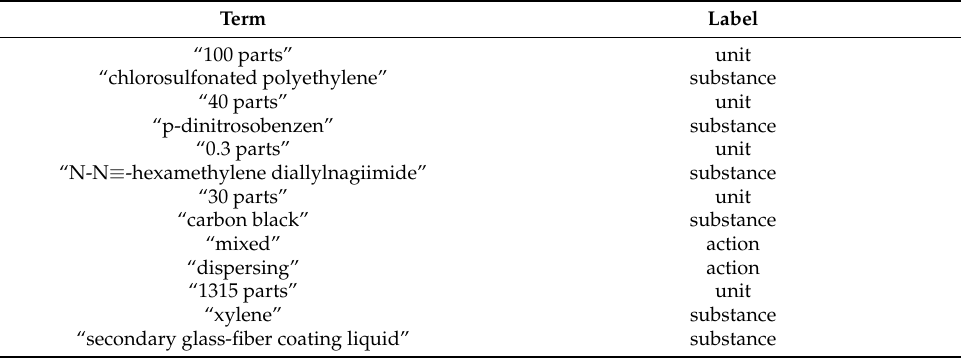
Table 5. Example list of chemical terms after labeling for patent